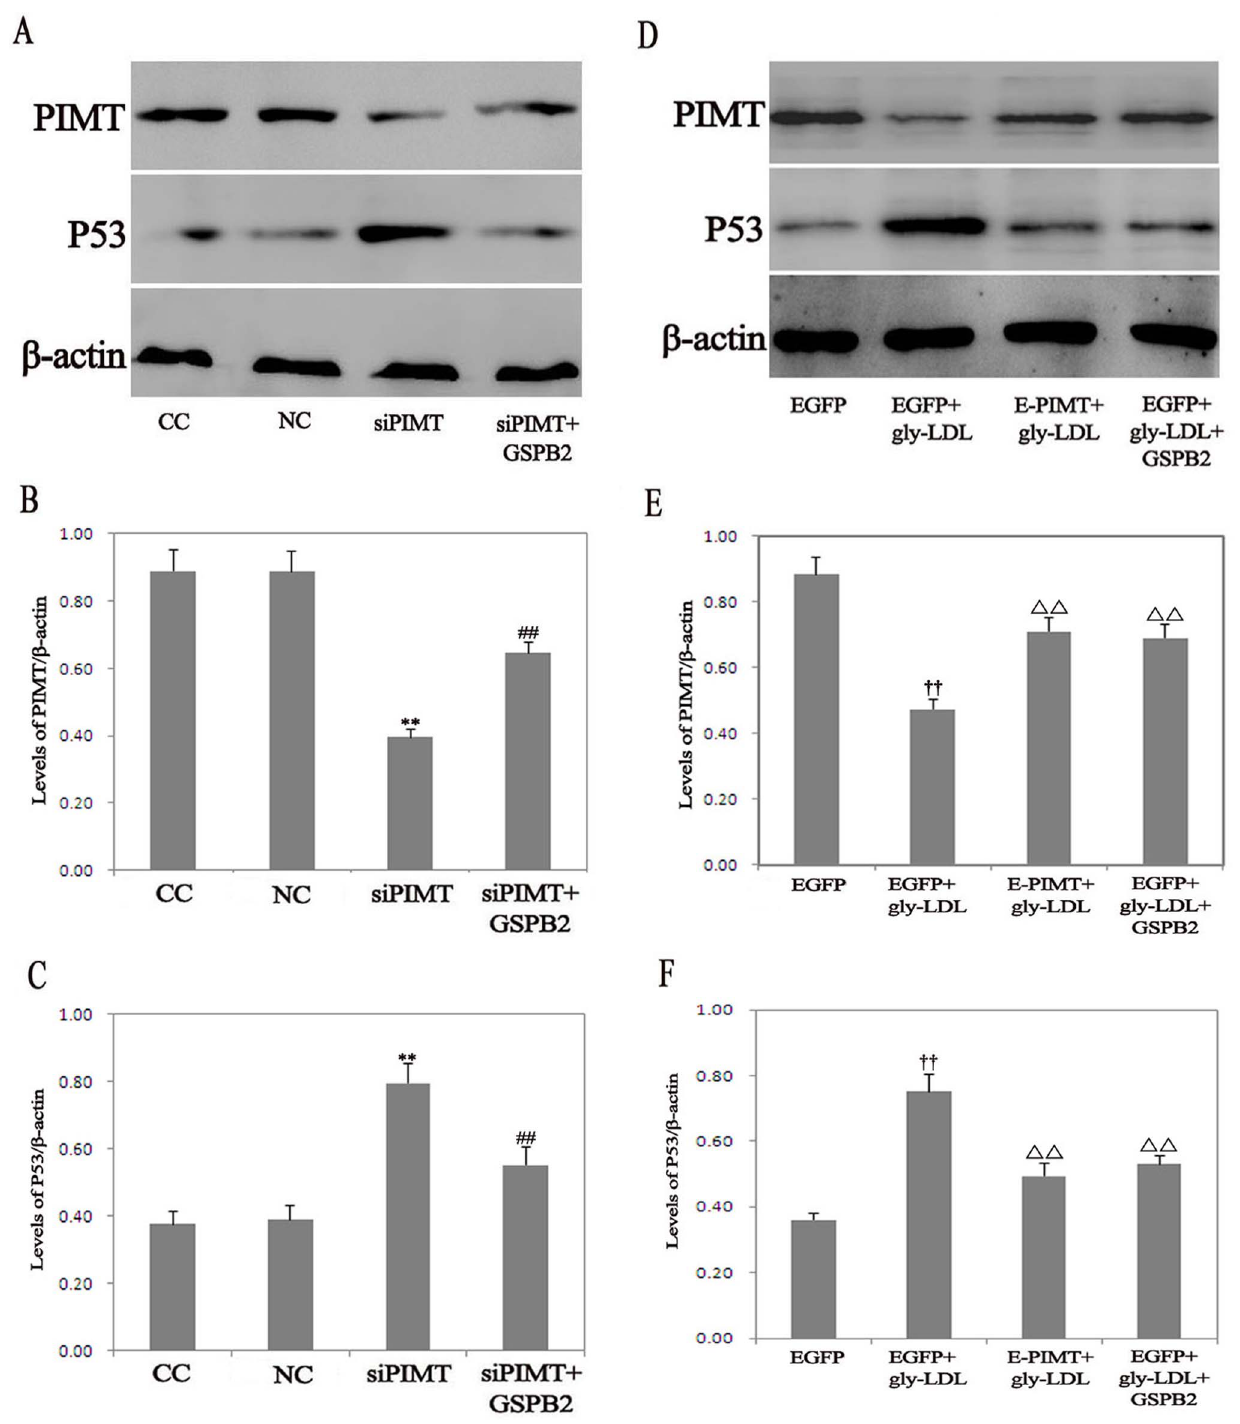
Figure 7. Effect of PIMT on the levels of p53 in HUVEC treated by gly-LDL. A, C: Effects of PIMT siRNA, GSPB2 on the expression of p53 in HUVEC. D, F: Effects of PIMT overexpression, GSPB2 on the expression of p53 in HUVEC treated by gly-LDL. B, E: Effects of GSPB2, gly-LDL on expression of PIMT in HUVEC. Data were expressed as the expression ratio of PIMT/ b -actin, p53/ b -actin and given as mean 6 SD from five independent experiments. * P , 0.05, ** P , 0.01 compared with NC group; # P , 0.05, ## P , 0.01 compared with siPIMT group. { P , 0.05, {{ P , 0.01 compared with EGFP group; D P , 0.05, DD P , 0.01 compared with EGFP + gly-LDL group.